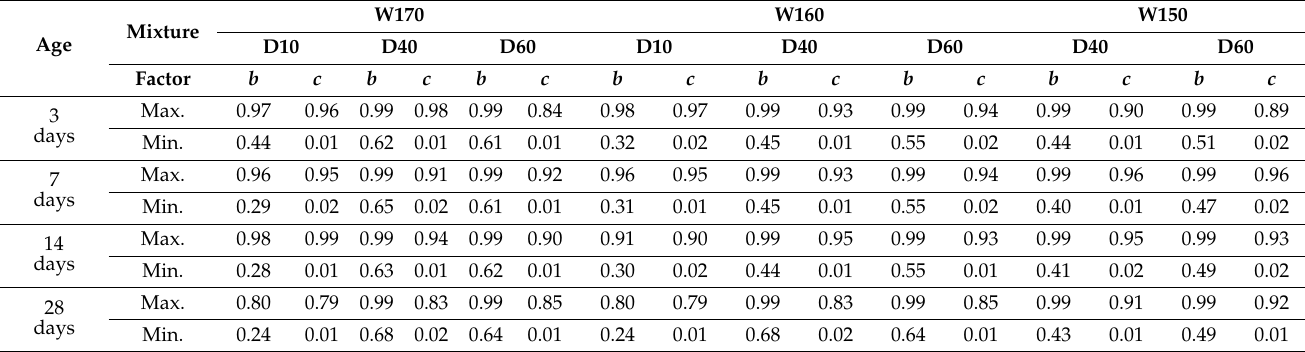
Table 5. Results of the calculated aggregate effect factors ( a > b > c , a =